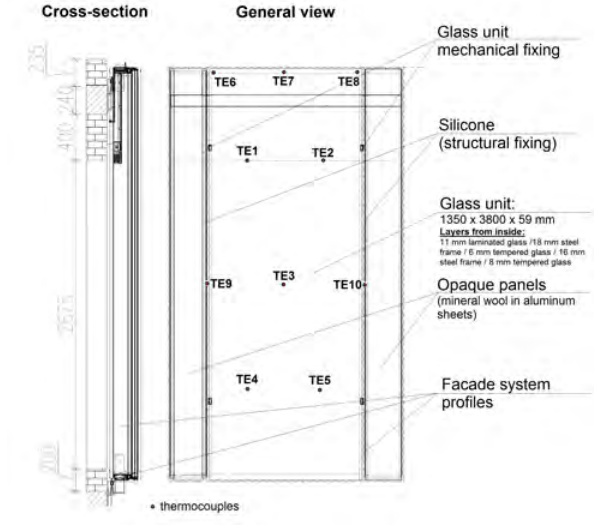
Figure 5: General view of tested specimen with location of thermo-